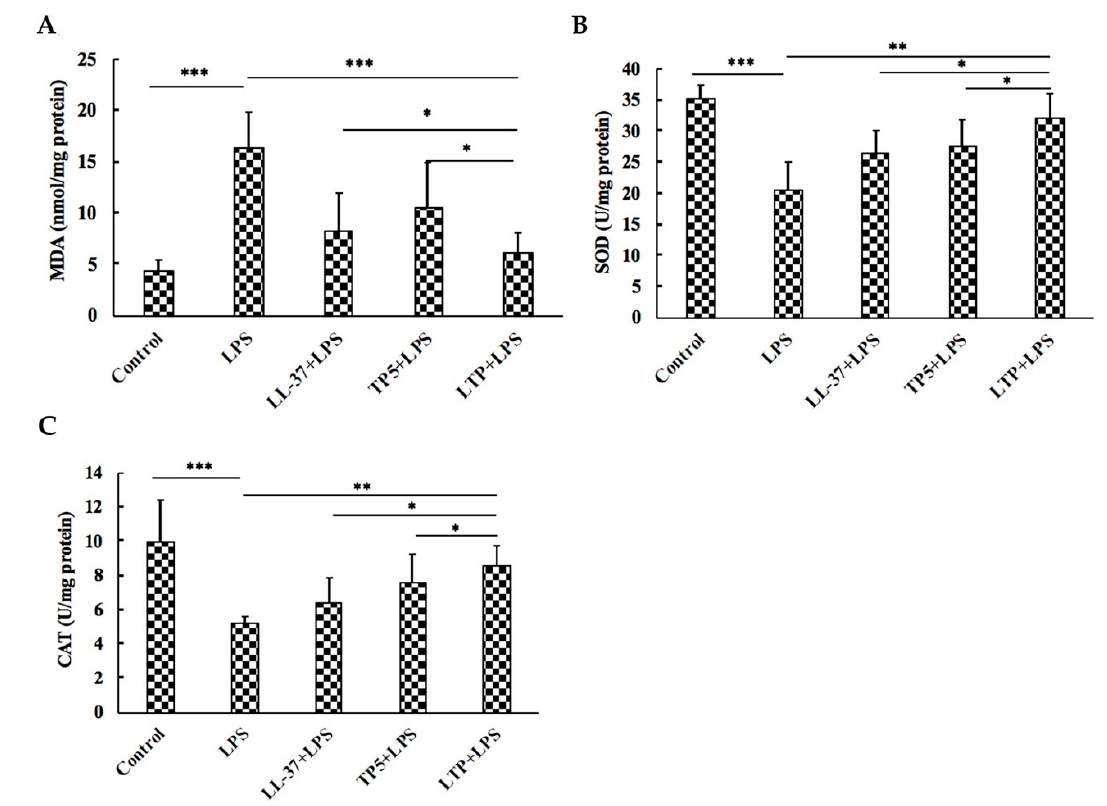
Figure 7. Effects of LTP on oxidative stress markers in the mouse jejunum. ( A ) MDA; ( B ) SOD activity; ( C ) CAT activity. Data are presented as means ± standard error from 12 biological replicates. *: p ≤ 0.05, **: p ≤ 0.01, ***: p ≤ 0.001.